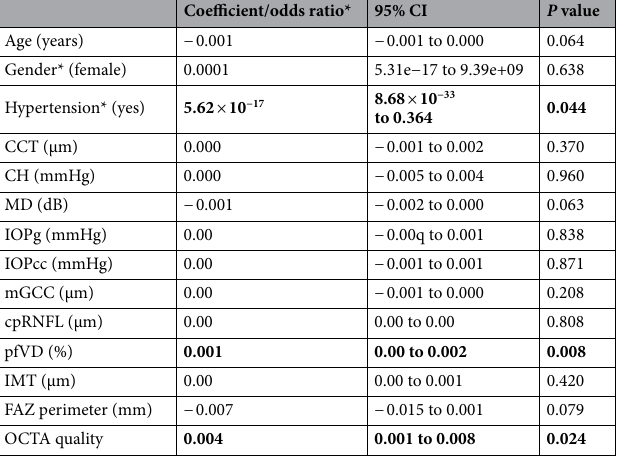
Table 4. Results of univariable regression analyses examine the relationship between MSFD and other variables. Values with a P -value < 0.05 are highlighted in